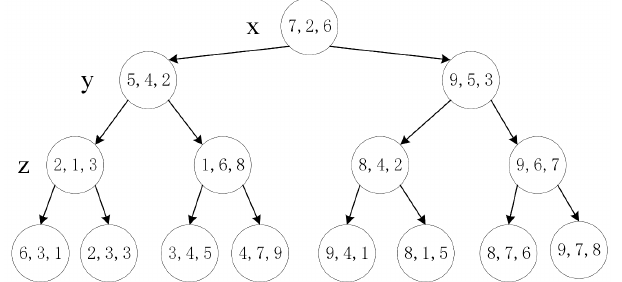
Figure 5. K-d tree sorting